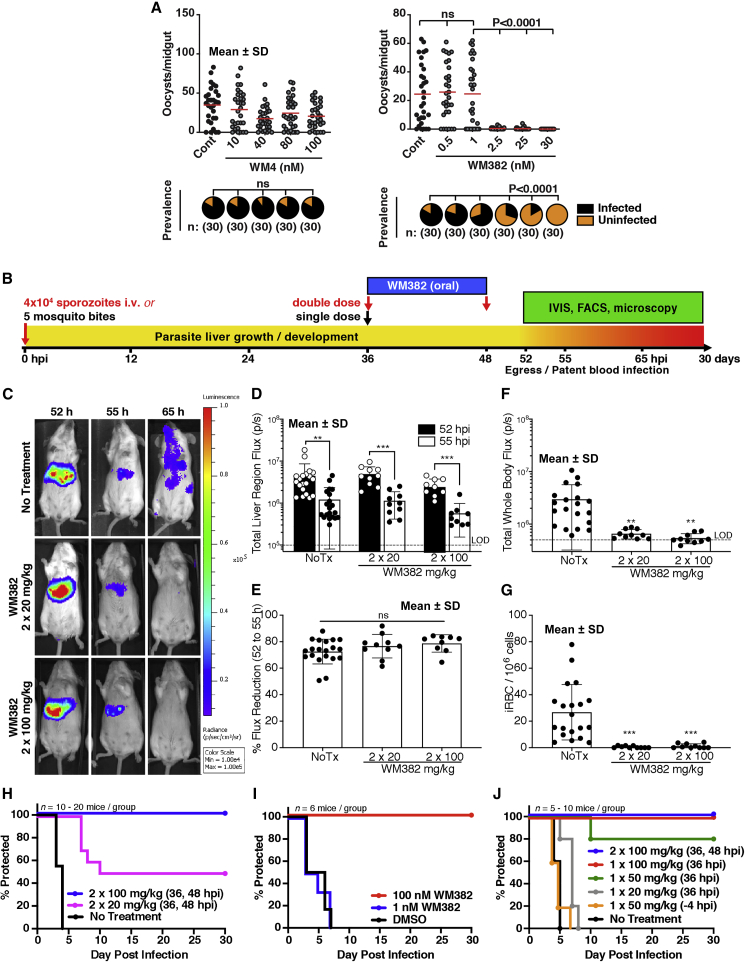
WM382 Prevents Transmission to Mosquitoes and Transition from Liver to Blood Infection(A) Oocyst counts from P. falciparum-infected mosquito guts for gametocytes treated with WM4 or WM382. Prevalence pies, proportions of mosquitoes with oocysts (black). Mean ± SD.(B) Mice were infected with five infectious mosquito bites (MB) or intravenous (i.v.) injection of 40,000 PbmCherryLuci sporozoites. From 52 h post infection (hpi), bioluminescence measured liver infection and egress, while bioluminescence and flow cytometry measured blood infection (Figure S6).(C) Bioluminescent images showing peak liver infection (52 hpi), liver egress (55 hpi), and blood infection (65 hpi) in WM382 treated and untreated mice.(D) Liver infection (52 hpi) was similar in all treatment groups and was reduced at 55 hpi. Mean ± SD.(E) Percentage loss of bioluminescence (egress) between 52 and 55 h. Mean ± SD.(F) Whole-body luminescence for blood infection at 65 hpi. Mean ± SD.(G) Blood parasitemia (FACS) at 65 hpi. Mean ± SD.(H) Time to patent blood infection for mice infected i.v. with sporozoites.(I) Time to patent blood infection following injection of 65 hpi supernatants from DMSO and WM382-treated P. berghei-infected HepG2 in vitro cultures.(J) Time-to-patent blood infection for mice infected with sporozoites by mosquito bite. Mean ± SD shown. ∗p < 0.05, ∗∗p < 0.01, ∗∗∗p < 0.001.Data in H–J represent 5 to 15 mice per group. LOD, limit of detection.